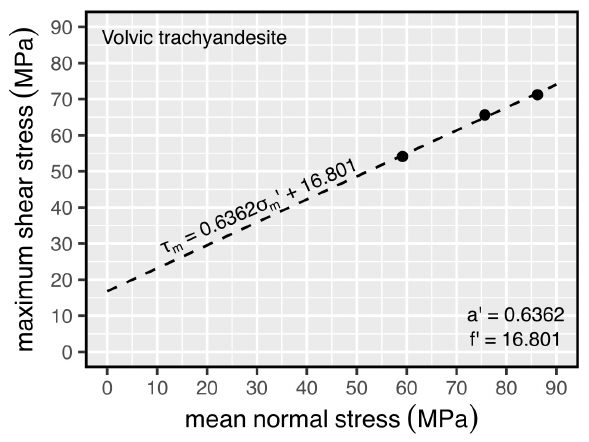
Figure 1: Example of plotting maximum shear stress as a function of mean normal stress for three triax- ial experiments on samples of Volvic trachyandesite (France; data from Heap and Violay [2021]). For Volvic trachyandesite, the linear regression fitting parame- ters required to calculate internal friction angle and cohesion (using Equations 1 and 2, respectively) are a ’ = 0.6362 ± 0.046738 and f ’ = 16.801 ±